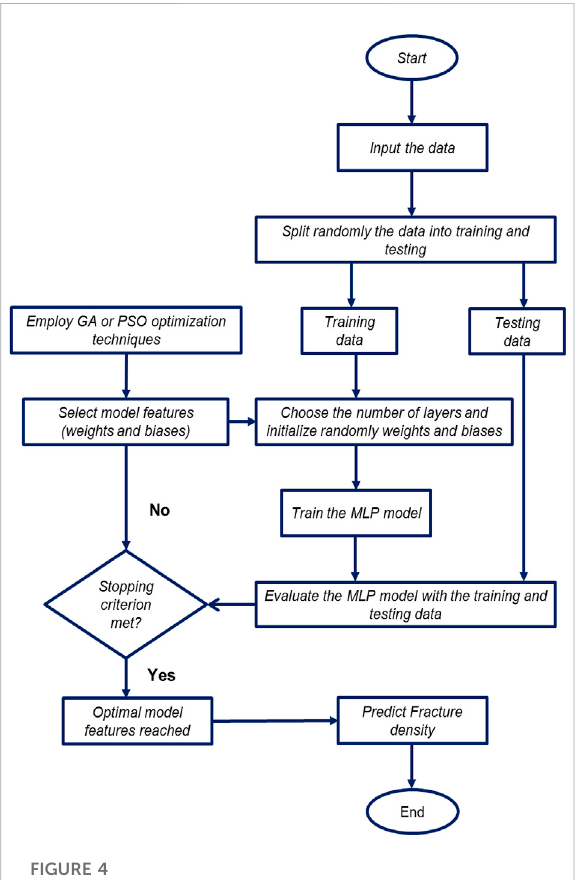
FIGURE 4 Flowchart for MLP-GA/PSO models used for prediction of fracture